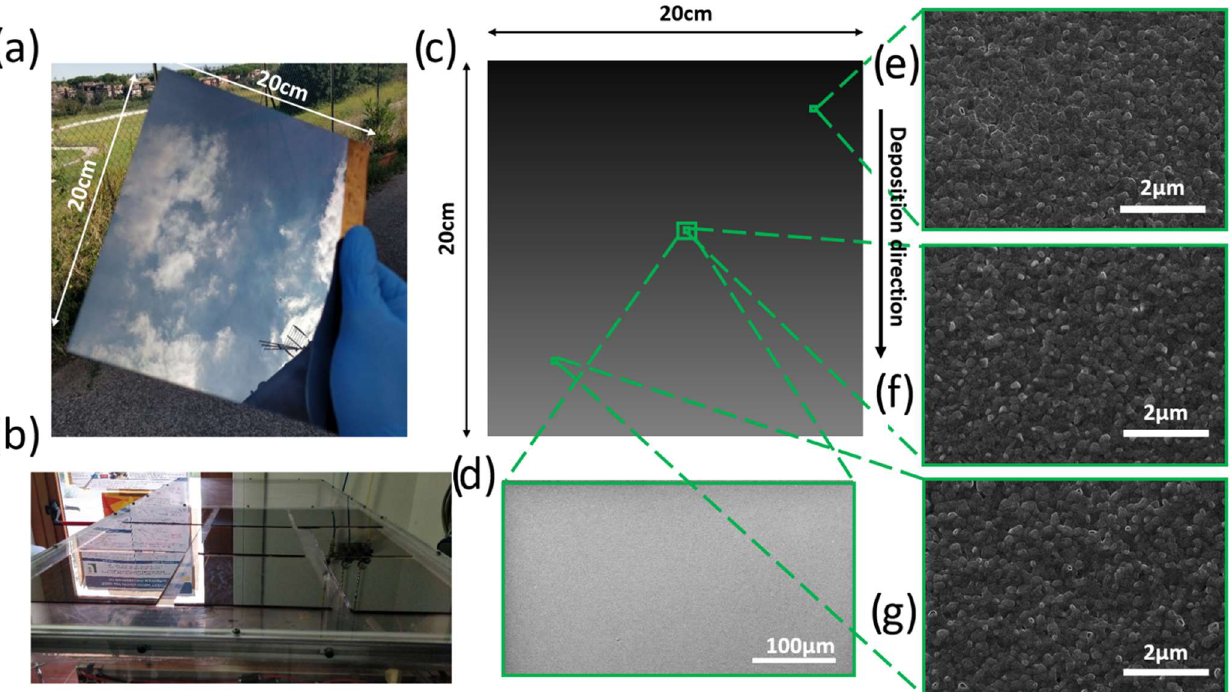
Figure 1. ( a , b ) Images of CsFA perovskite depositions in an air environment (with relative humidity of 20–30%) using a semi-automatic blade and slot die coater. ( c ) Scheme of the perovskite substrate size to show where SEM images where taken. ( d – g ) SEM images with 100 μm ( d ) and 2 μm ( e – g ) scale bars.